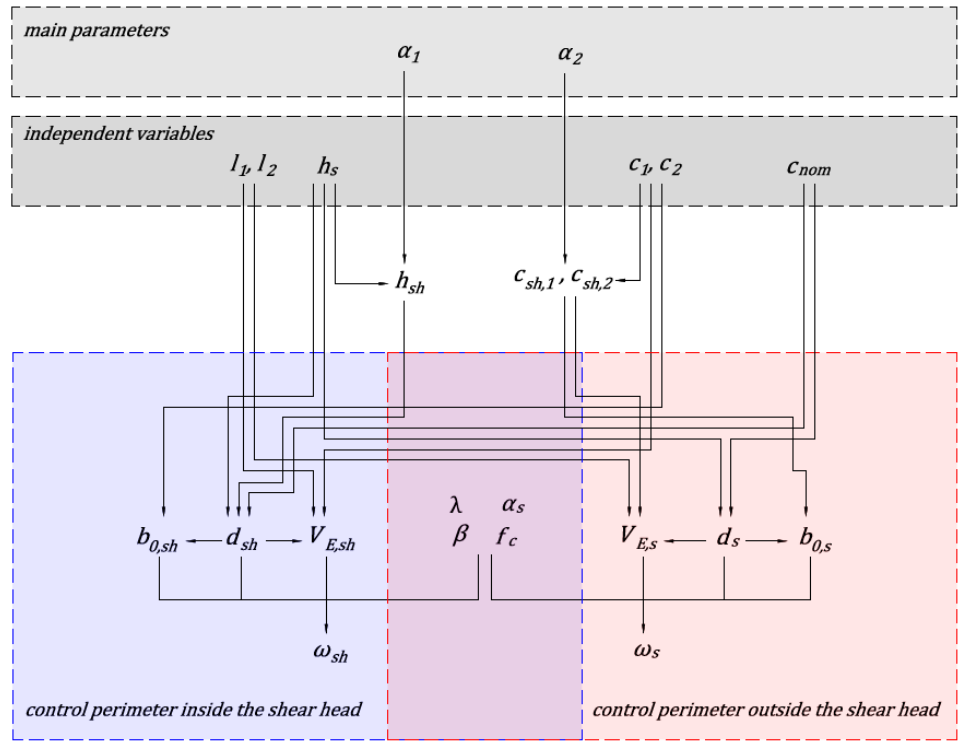
Figure 4. Parameters dependency diagram for ACI 318 code.